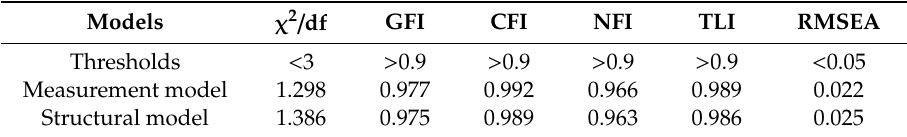
Table 4. Goodness-of-fit indices.